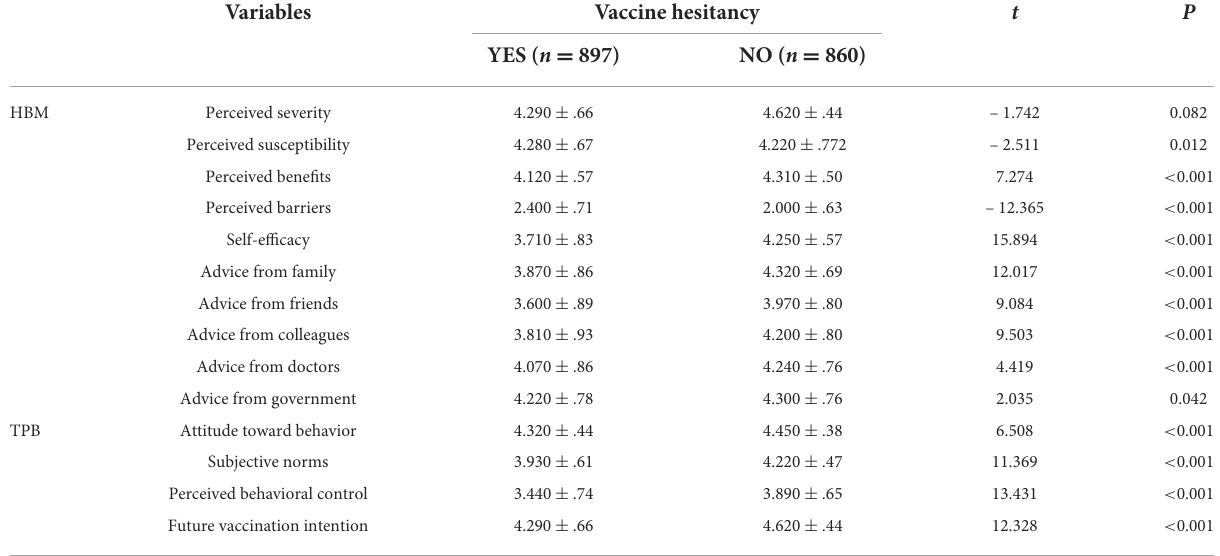
TABLE 2 Univariate analysis between HBM and TPB variables and the hesitation to vaccinate with